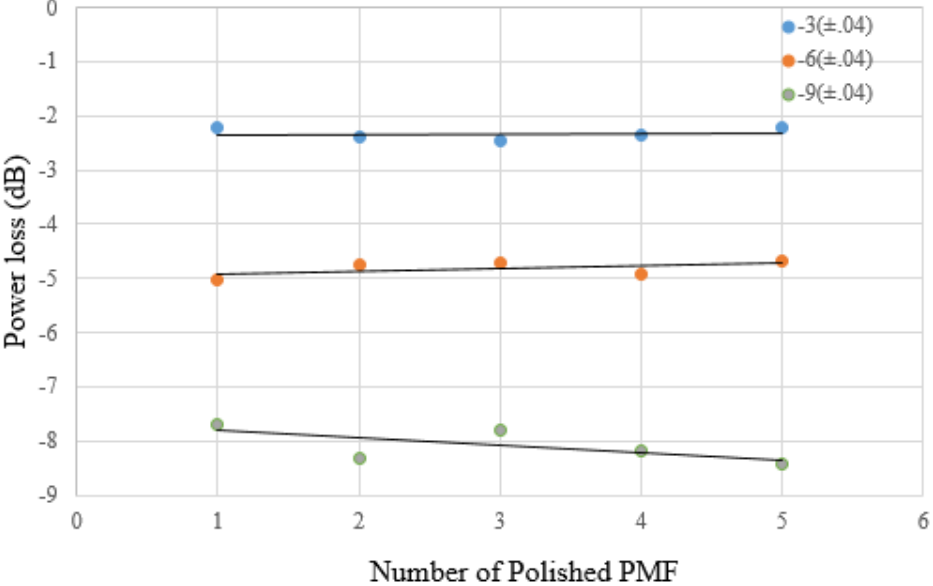
Figure 2. Power loss of each polished PMF (during and after the polishing process), three sets of PMFs (each set contains five optical fibers) were polished until transmission power loss was reached at −3(±0.04), −6(±0.04) and −9(±0.04) dB, respectively .